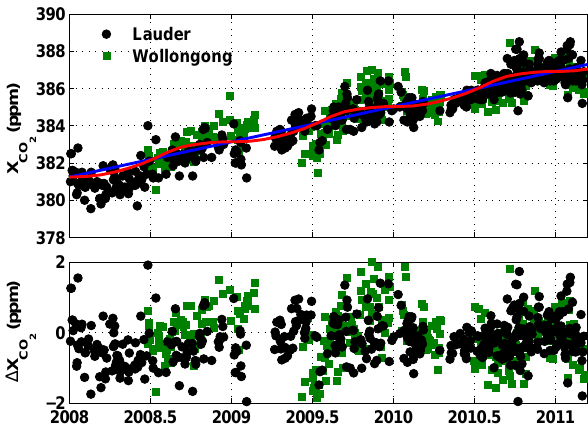
Fig. 2. Three slices of the atmospheric CO 2 are plotted for the three HIPPO flights at different times of the year. Most of these data were measured over the Pacific Ocean. There is generally smaller variability in the Southern Hemisphere south of 25 ◦ S (indicated by the solid vertical black line) than in the Northern Hemisphere. 99.9% of the filtered ACOS-GOSAT data in the Southern Hemi- sphere south of 25 ◦ S lie between 25 ◦ S and 55 ◦ S (indicated by the dashed vertical black line). The black circles are the pressure- weighted mean mixing ratios at each 5-degree latitude bin, with their values on the right axis. Note that the black circles are not total column amounts, and will be affected by missing data in the stratosphere.